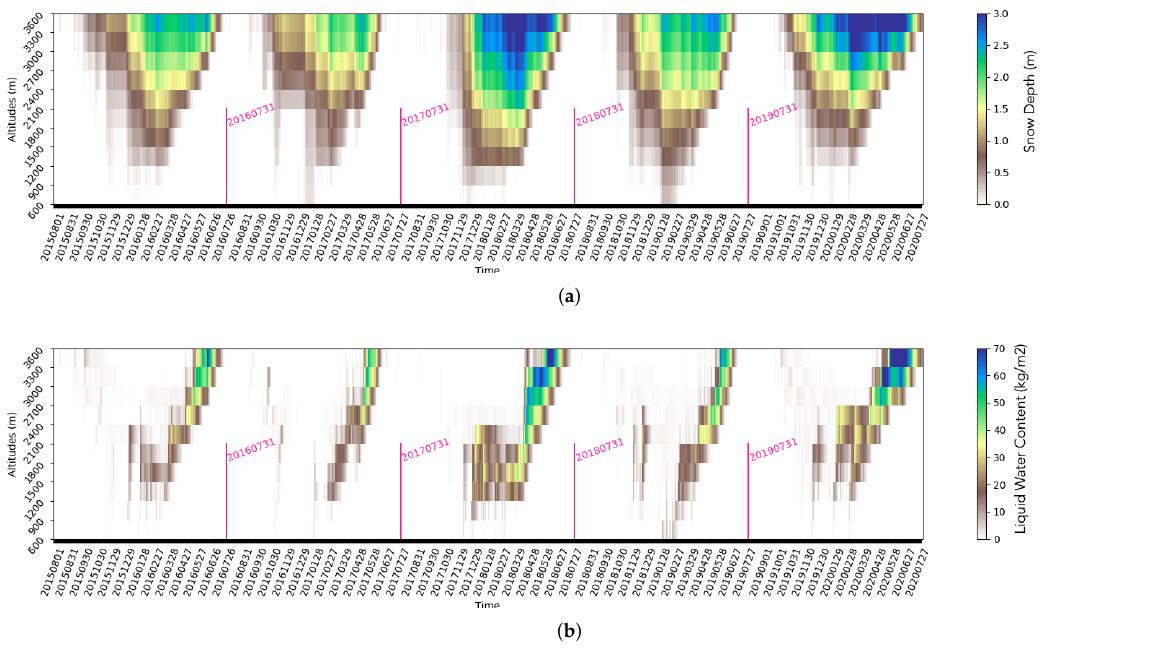
Figure 15. Time evolution of ( a ) snow depth (in meters) and ( b ) liquid water content (in kg/m 2 ) simulated by Crocus at the Grandes-Rousses scale for the northern orientations from 2017 to